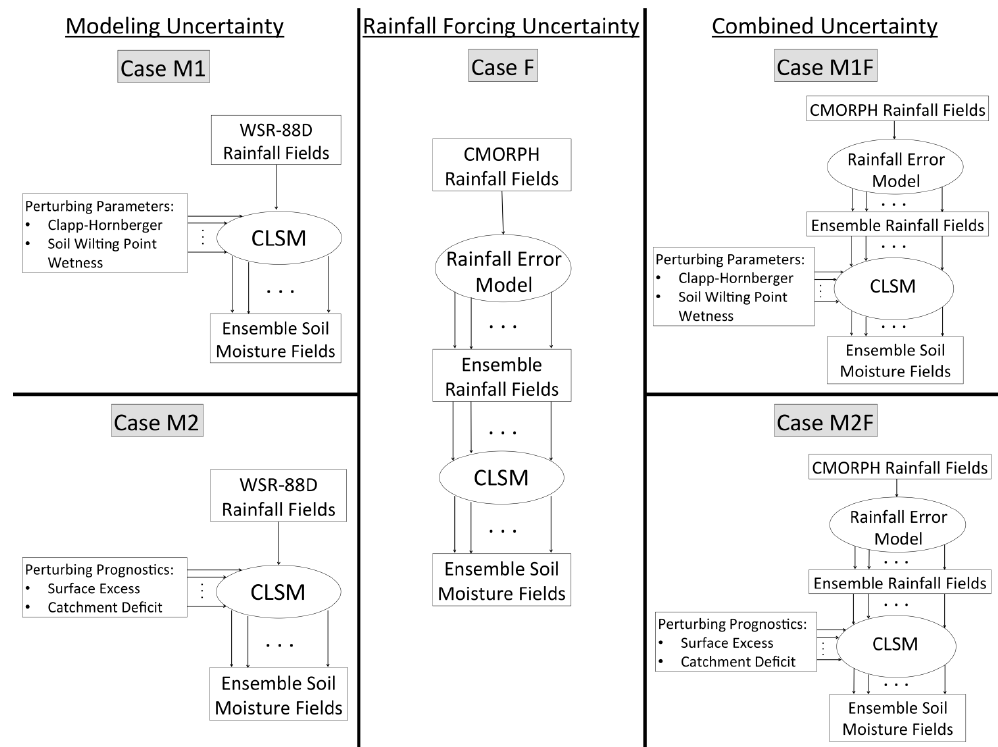
Figure 2 Experimental setup showing the methodology used to investigate model uncertainty alone (left column), rainfall-forcing uncertainty alone (middle column), and rainfall-forcing uncertainty combined with model uncertainty (right column).